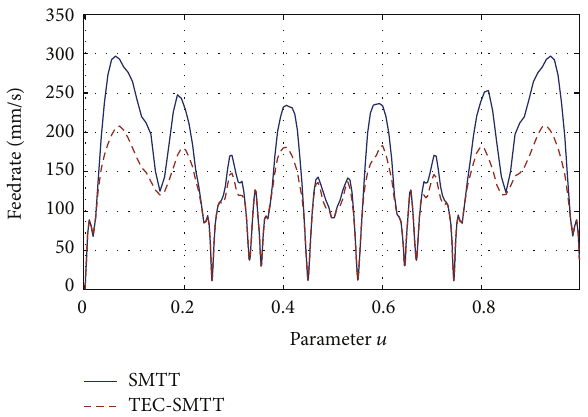
Figure 11: Planned feedrate trajectories of the SMTT (solid line) and TEC-SMTT (dash line).